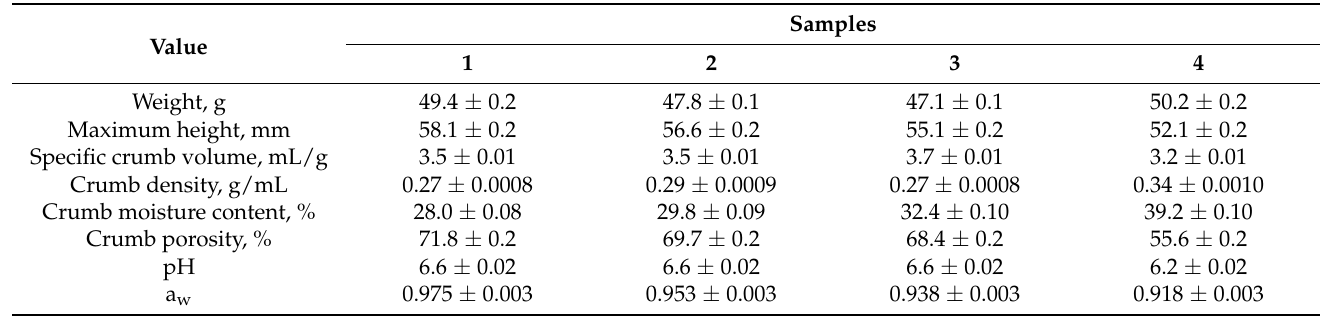
Table 7. Physicochemical properties of bread samples with microalgae.